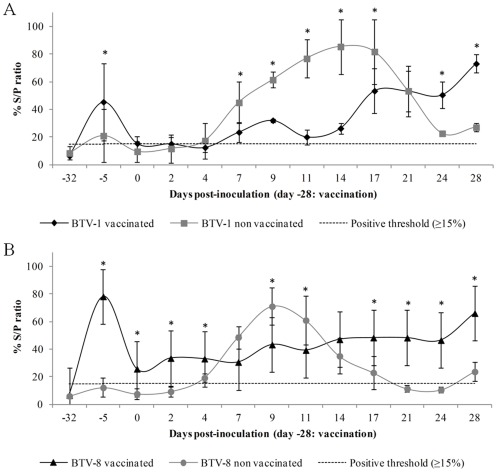
ELISA antibody response after BTV vaccination and experimental infection.Evolution of mean percentages (O.D. sample/O.D. positive control ×100) with standard deviation of VP7 antibodies for each group of vaccinated and non vaccinated ibexes challenged with BTV-1 (A) and BTV-8 serotypes (B).